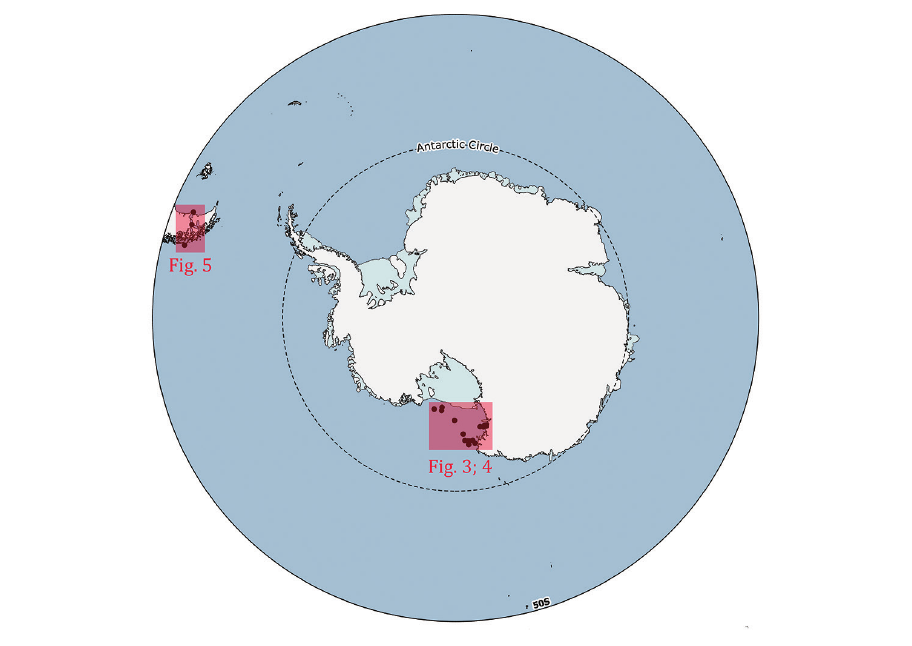
Figure 2. General map of Antarctica with the study areas highlighted (red boxes). Detailed maps of the sampling areas are provided in Figs